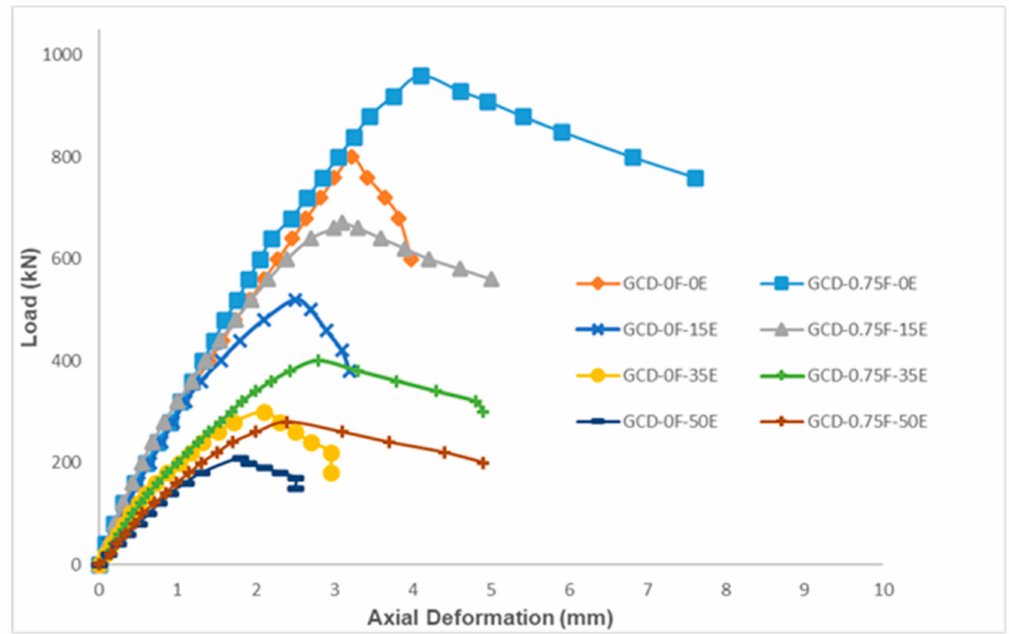
Figure 11. The axial load–axial displacement behavior of GCD